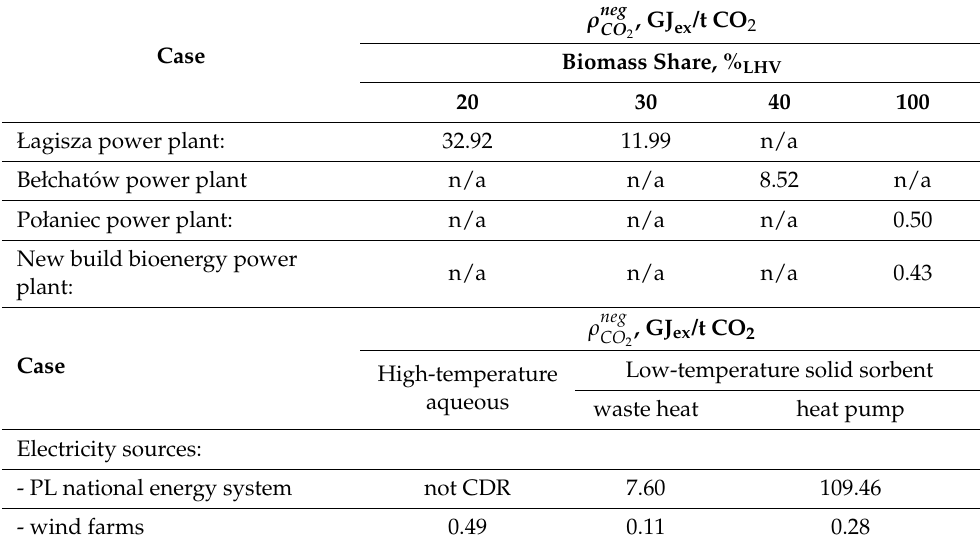
Table 8. Specific thermo-ecological cost of negative CO 2 emissions for the analyzed CDR.